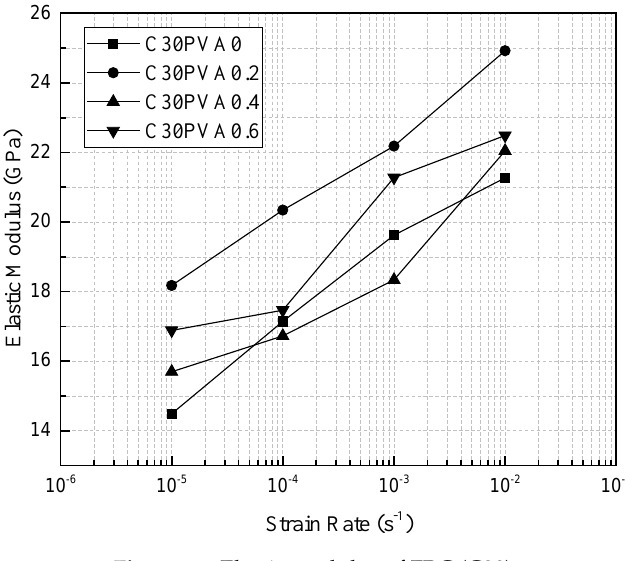
Figure 10. Elastic modulus of FRC (C30).